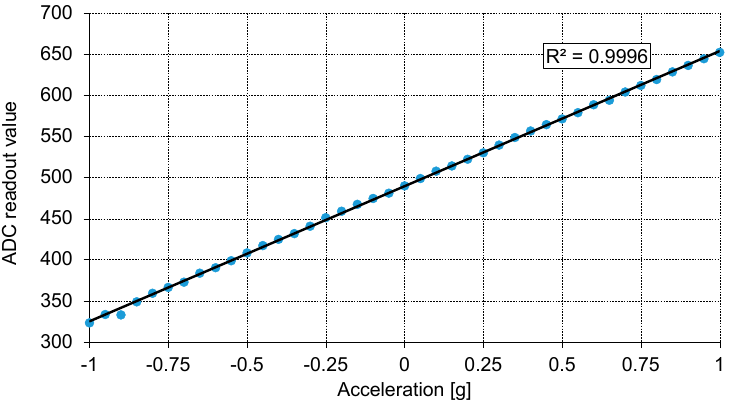
Figure 17. The output of the ROIC of the X-axis sensor as a function of gravitational acceleration.